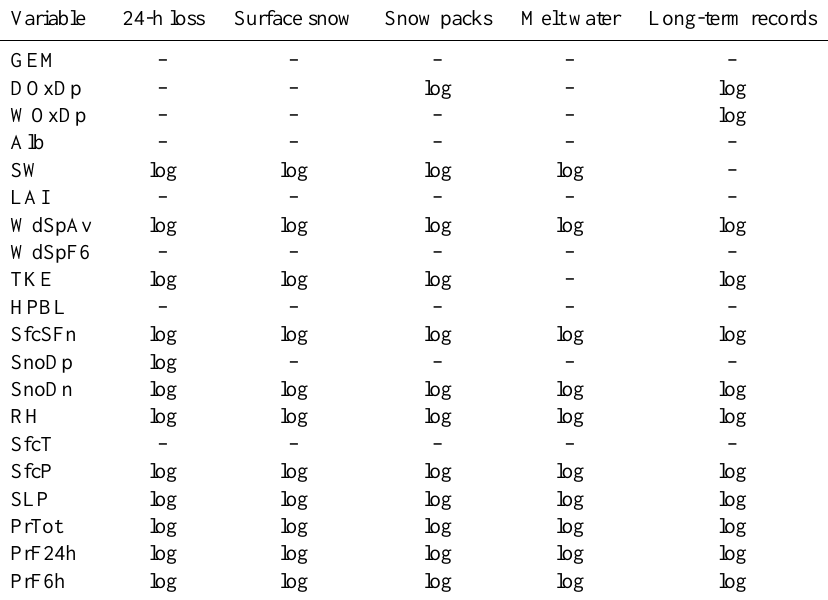
Table 8. Transformations of environmental